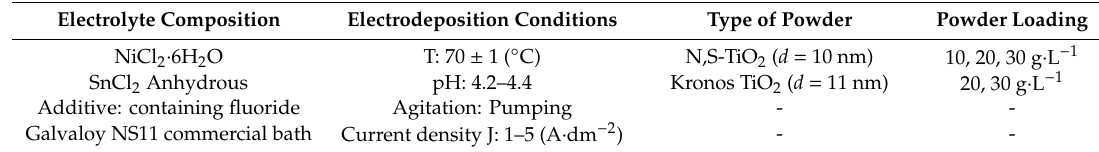
Table 1. Overview of the electrodeposition parameters for the preparation of pure Sn–Ni coatings and Sn–Ni composite coatings reinforced with di ff erent types of doped TiO 2